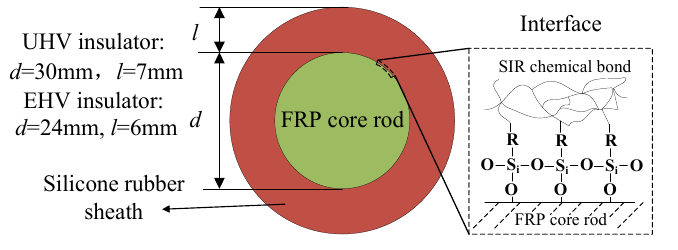
Figure 2. Structure of short sample.